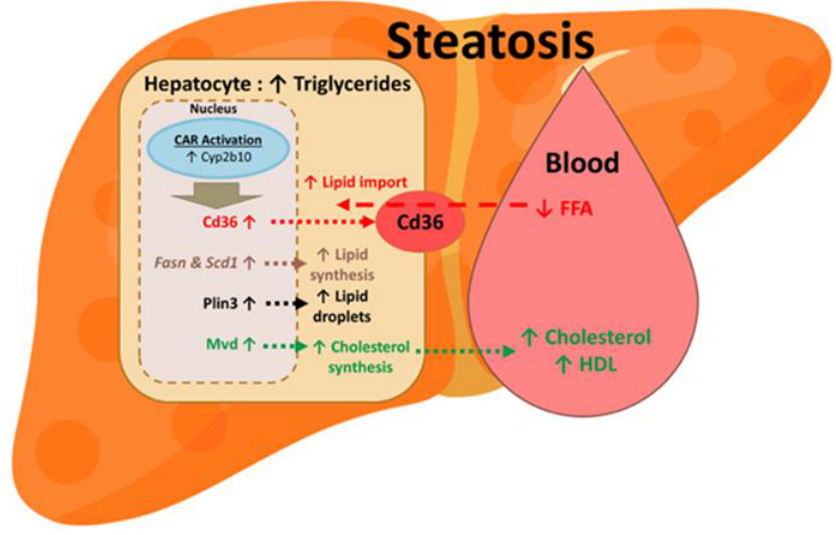
Figure 5. Suggested mechanisms of steatosis and metabolic disruption induced by pesticides. Constitutive androstane receptor (CAR), fatty acid transporter ( Cd36 ), fatty acid synthase ( Fasn ), stearoyl-CoA desaturase ( Scd1 ), perilipin 3 (Plin3), mevalonate diphosphate decarboxylase ( Mvd ), FFA, and HDL.